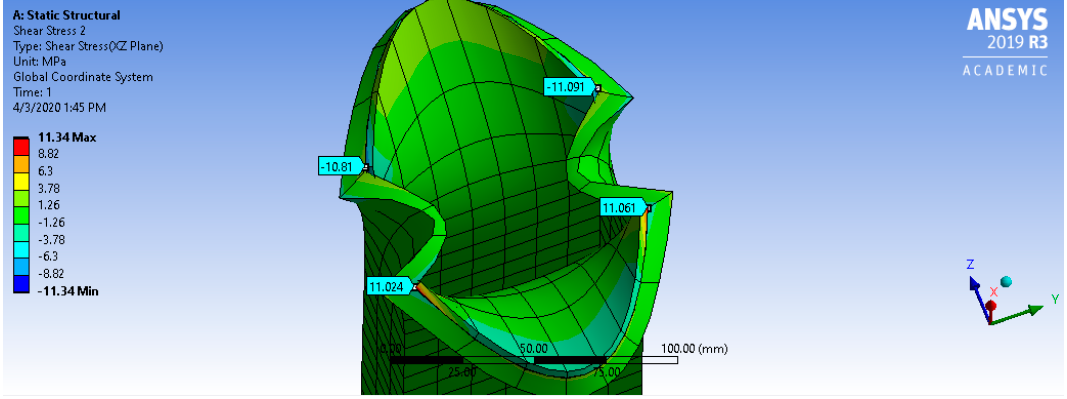
Figure 17. Shear stress at the interface between the glass sheets and HDPE for the 89 × 38 × 3 × 1 GRCC.